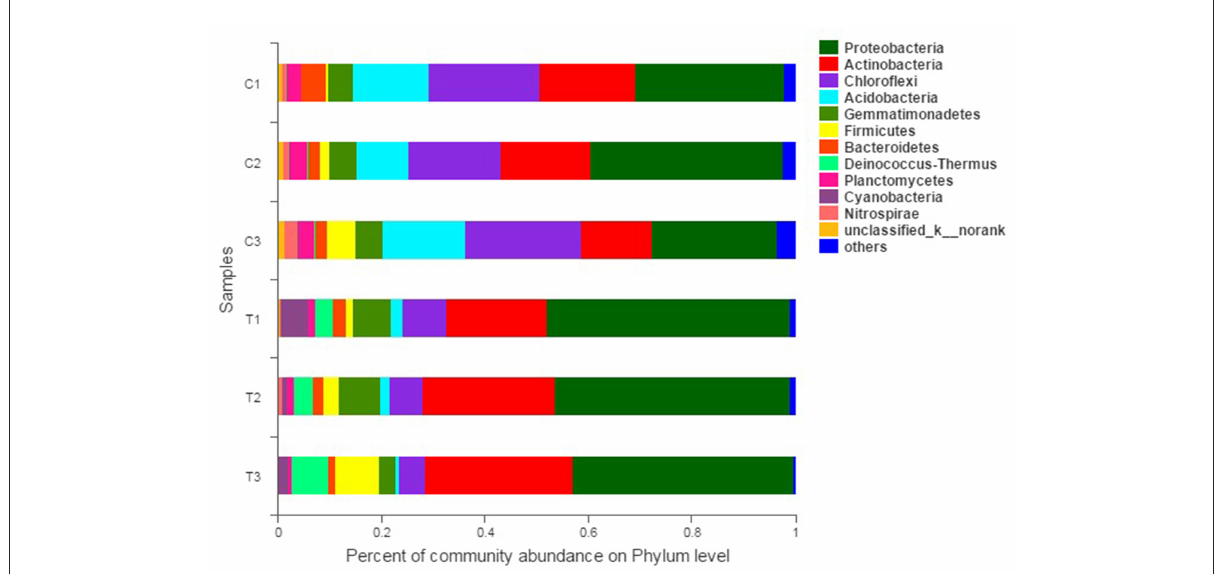
FIGURE4 Bacterial community compositions and structures of soil samples. Bar diagrams were made to present the relative abundance levels at the phylum level of all samples. All data in the experiment represent three independent experiments.